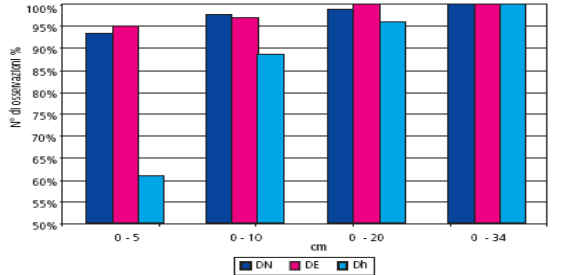
Figure 5. Distribution of the differences between static and real time survey